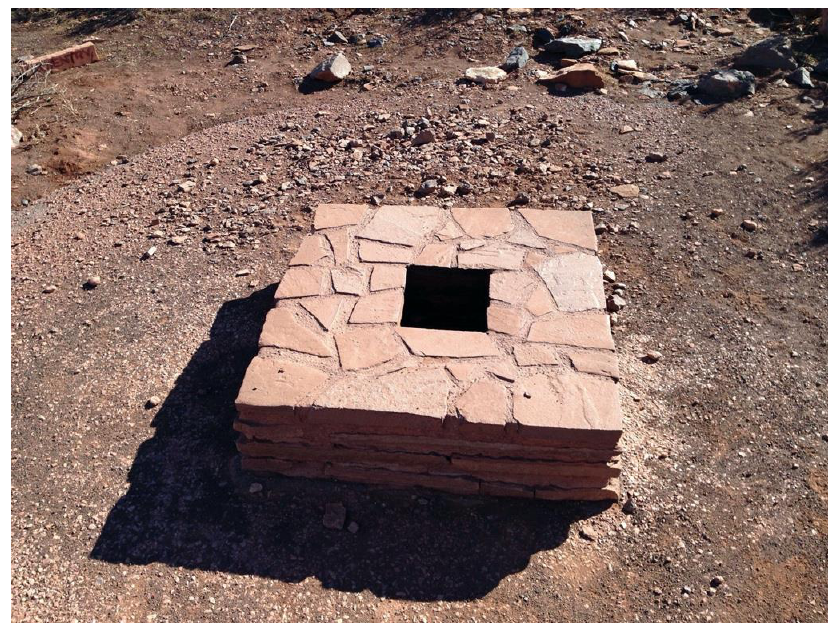
Figure 13. Wupatki Blowhole with the NPS Flagstone Cap [51].